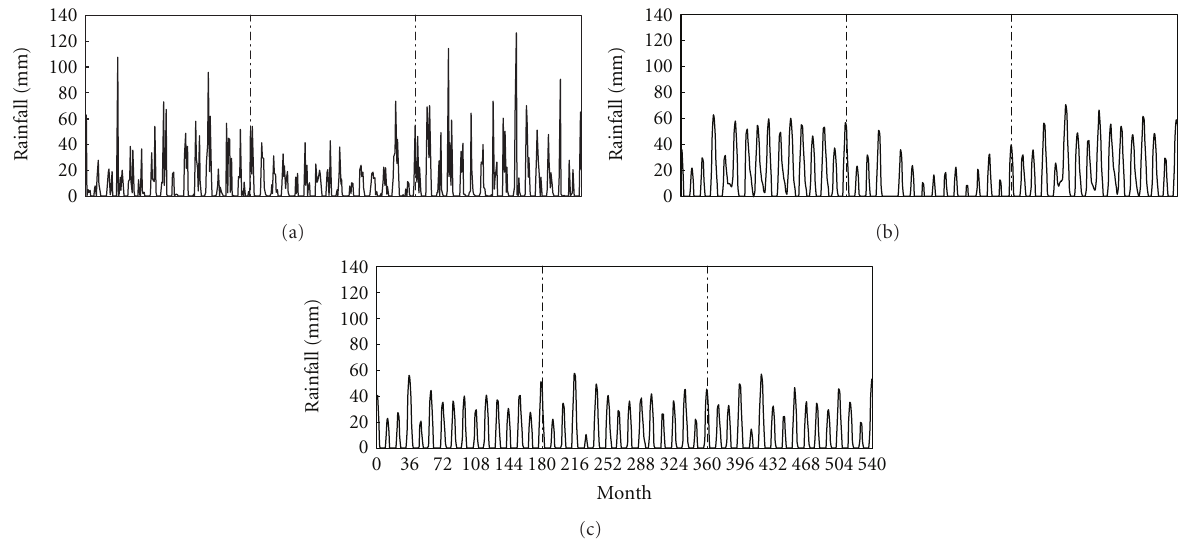
Figure 4: Monthly total rainfall for the weather station of Kuwait Airport for the time duration from January 1965 (corresponding to month number 0) to December 2009 (month number 540): (a) actual dataset; (b) calculated records based on periodic model; (c) calculated records based on periodic model with excluding period 360